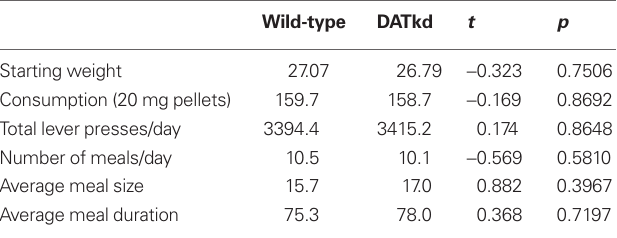
Table 1 | Comparison of baseline behavior between